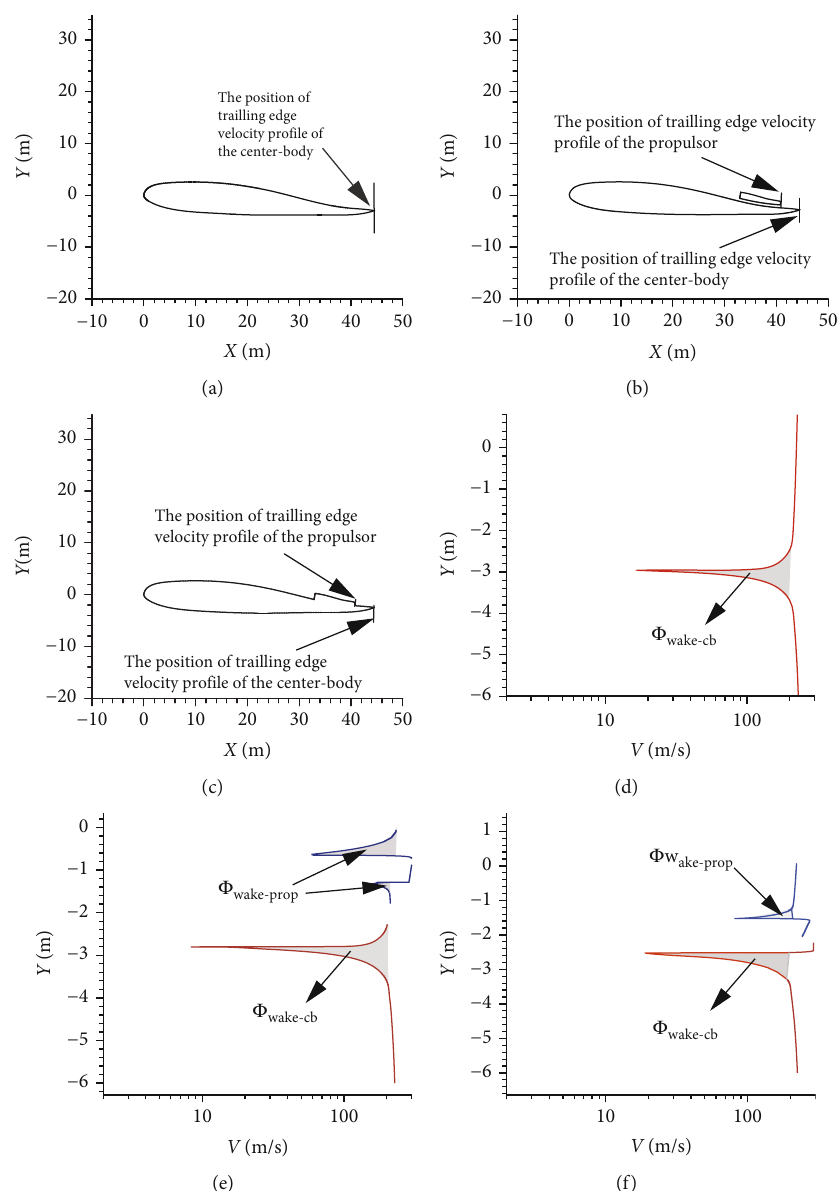
Figure 16: Trailing edge velocity pro fi les for C (d – f) Trailing edge velocity pro fi les of center body and propulsor for C